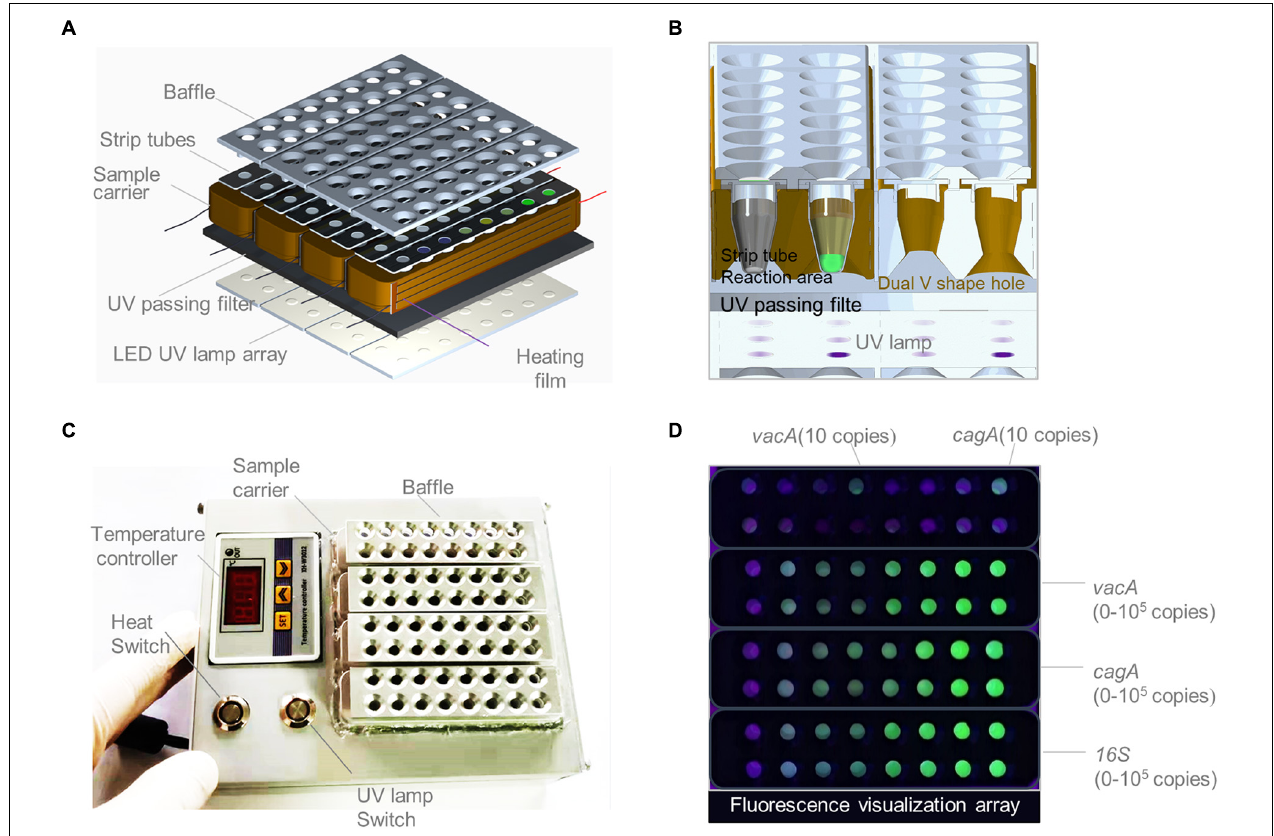
FIGURE 6 | Schematics of a portable array detector (Pad-VATA) for visual analysis of thermostatic nucleic acid amplification and its performance assessment. (A) Schematic diagram of the layered structure of the Pad-VATA device, which from up to bottom consists of a baffle plate, a strip tube, a heating film, a UV through filter, and an array of LED UV lamps. (B) The operating principle of the Pad-VATA core detection module. (C) Physical diagram of Pad-VATA. It is divided into temperature controller module, heating switch module, UV lamp switch module, and decoding function module. The sample was put into the well after the device is powered on, then turn on the heating switch and UV switch to perform the whole sample reaction process. (D) The results of different diluted samples detected by the one-tube RPA-CRISPR platform in 20